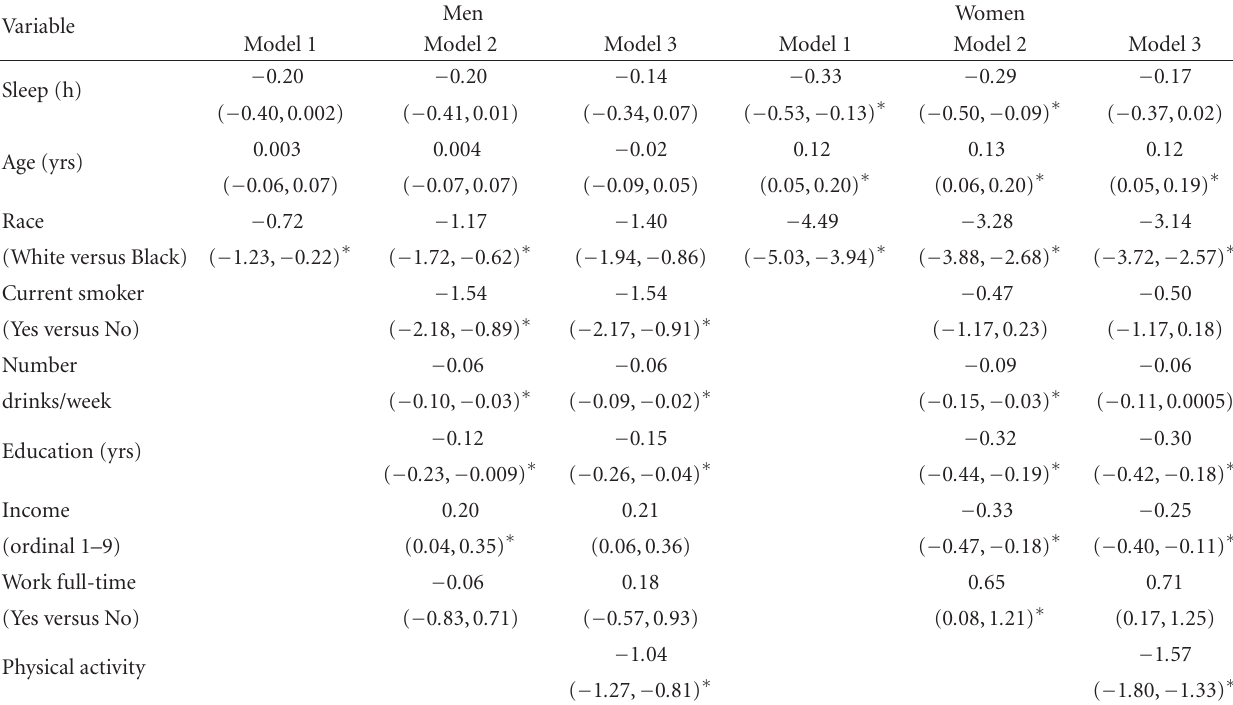
Table 3: Multivariate models for predictors of body mass index in the CARDIA study stratified by gender ( β ,95% CI) 1 .